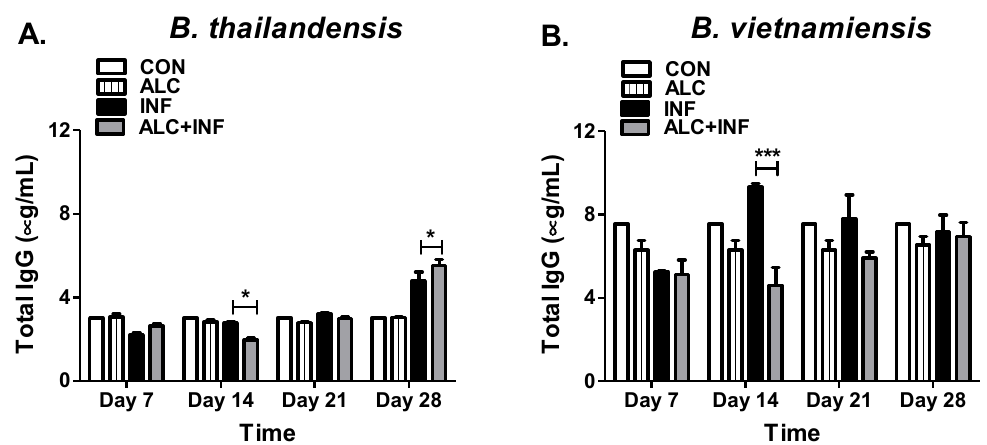
Figure 4. Total IgG concentration in mice infected with B. thailandensis or B. vietnamiensis . Mice were treated as described in Figure 3 and intranasally infected with ( A ) B. thailandensis or ( B ) B. vietnamiensis (1 × 10 5 ). Whole blood was collected weekly until 28 days PI. Total IgG in mice were